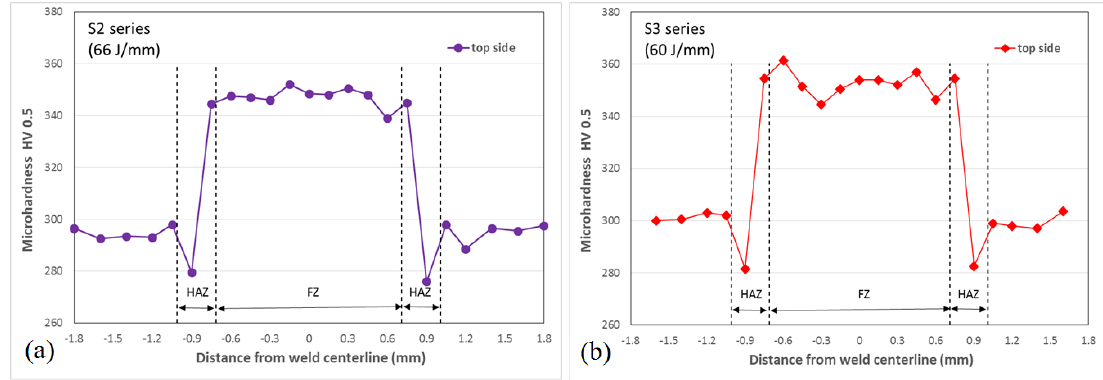
Figure 4. Hardness profiles of the welded series. ( a ) S2 series and ( b ) S3 series.